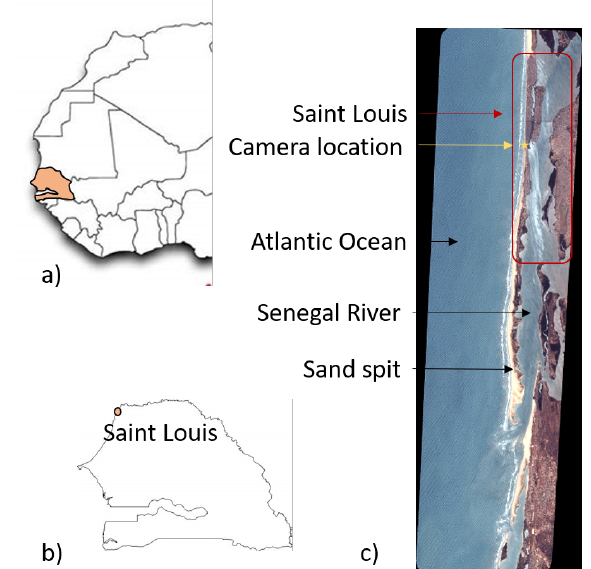
Figure 1. (a) Location of Senegal on Africa’s map. (b)